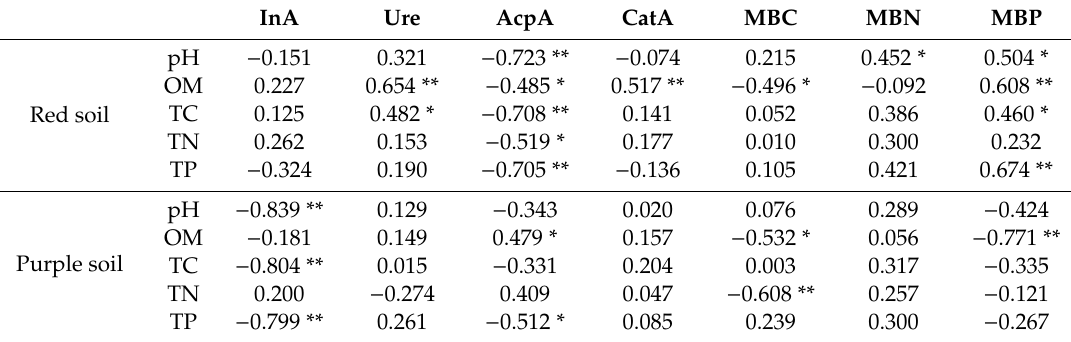
Table 5. Pearson’s correlation coe ffi cients of soil chemical properties and microbial